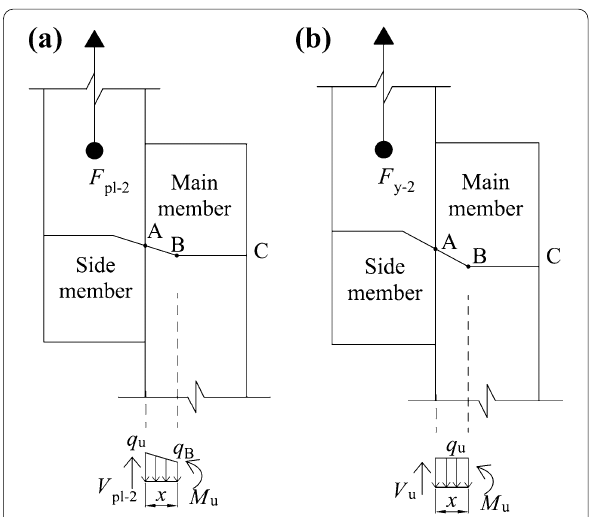
Fig. 13 Mechanical yield models I ( a ) and II ( b ) including their corresponding section free-body diagrams of single staple legs in single-shear plywood-to-plywood single-staple connections used to derive lateral loads F pl and F y in Stage 2, − 2 − 2